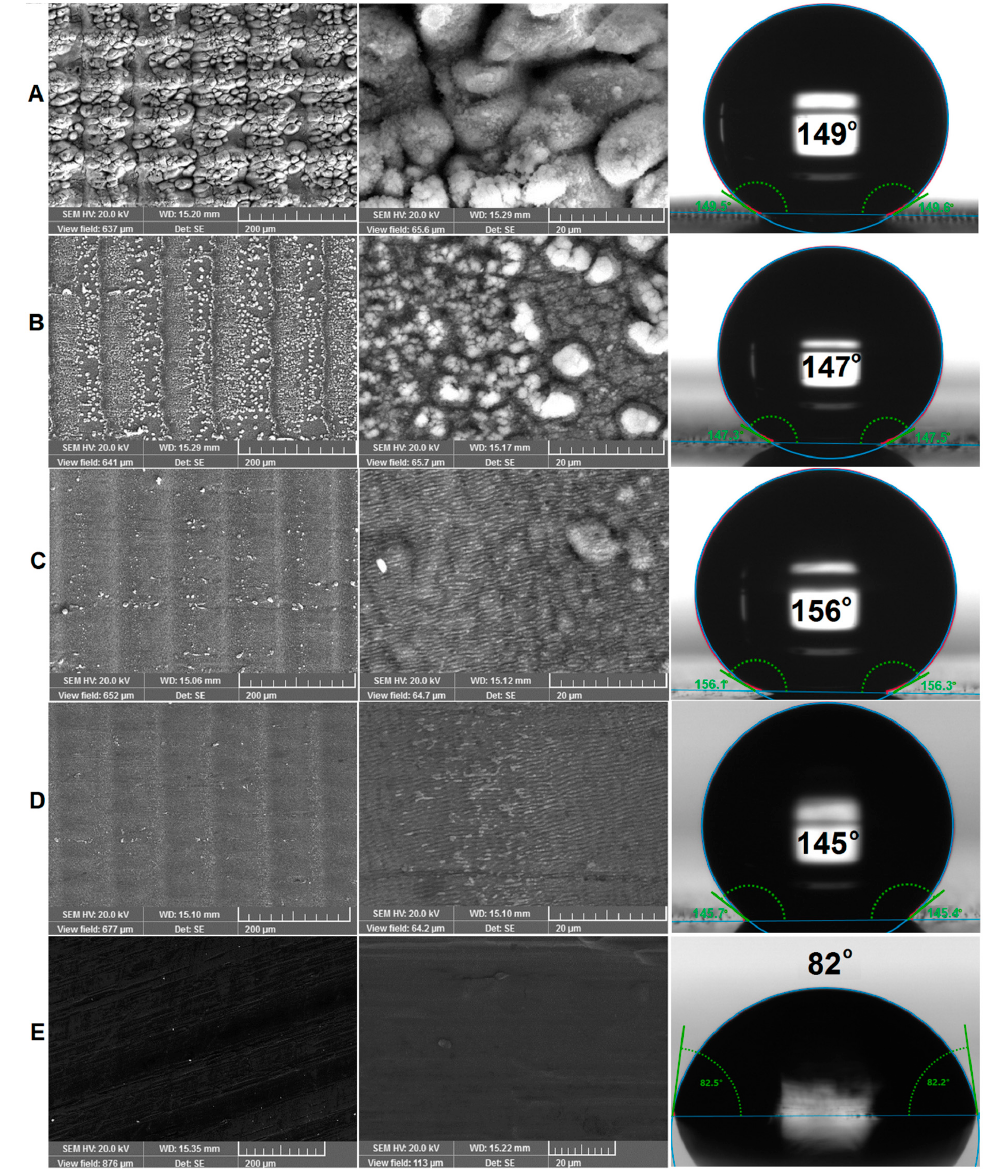
Figure 6. Contact angle measurements obtained by drop shape analyzer for different colors produced on aluminum along with the SEM images. The images correspond to ( A ) black, ( B ) brown, ( C ) golden, ( D ) multicolor and ( E ) untreated aluminum. Most treated surfaces demonstrated superhydrophobic